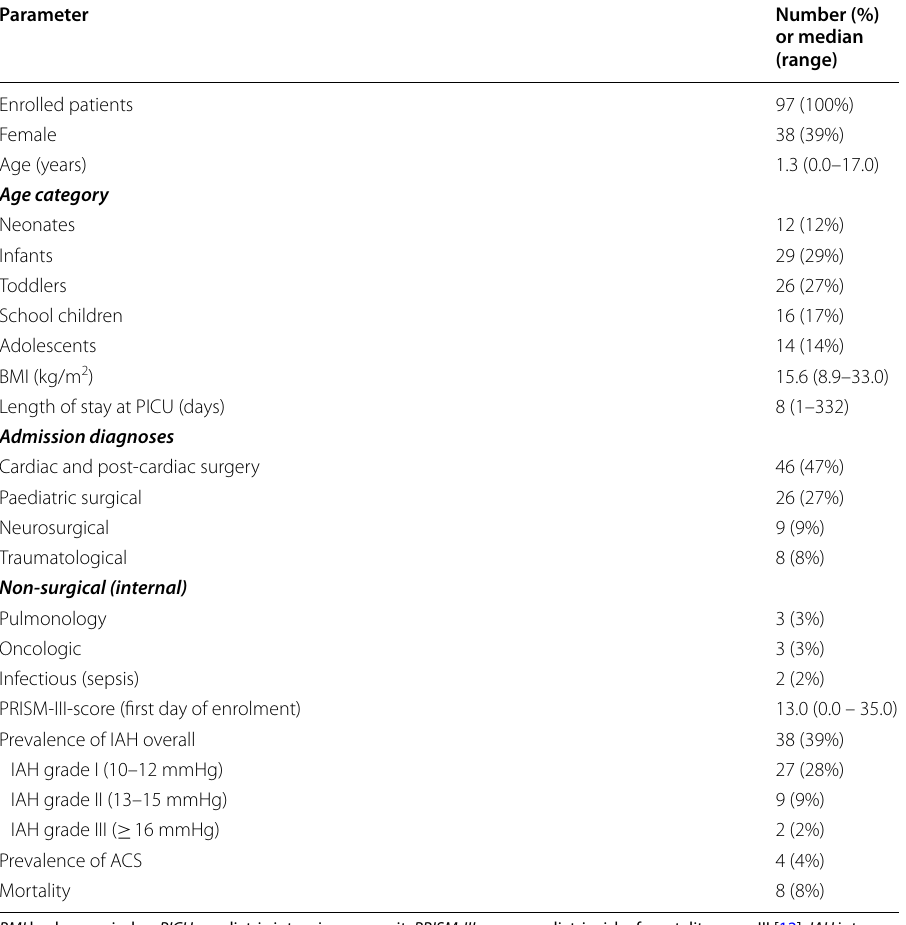
BMI body mass index, PICU paediatric intensive care unit, PRISM-III-score paediatric risk of mortality score III [12], IAH intra‑ abdominal hypertension, ACS abdominal compartment